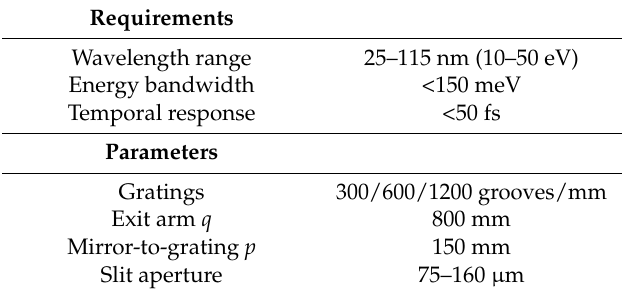
Table 1. Requirements and parameters for a TDC monochromator with sub-150 meV energy bandwidth.